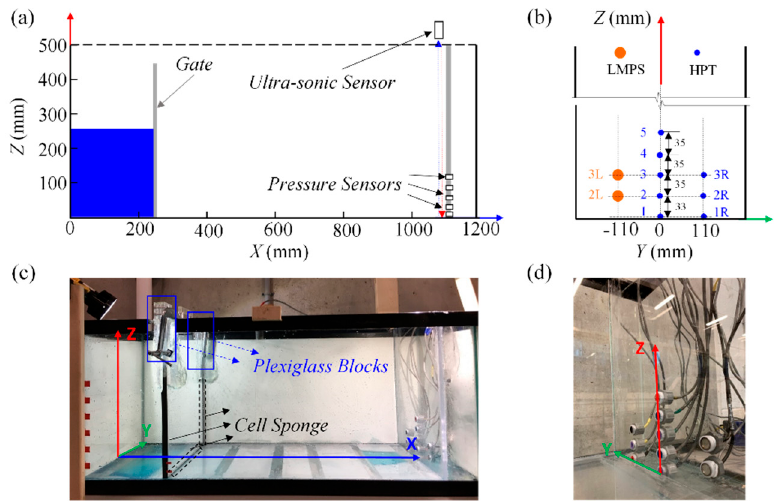
Figure 1. Experimental setup and the adopted coordinates system: ( a ) schematic of the experimental setup in initial condition; ( b ) side view schematic of the experimental tank and the positioning of TE connectivity LM − series Pressure Transducers (LMPT) and Honeywell Pressure Transducers (HPT); ( c ) side-view image of the experimental tank; d) pressure transducers’ location.